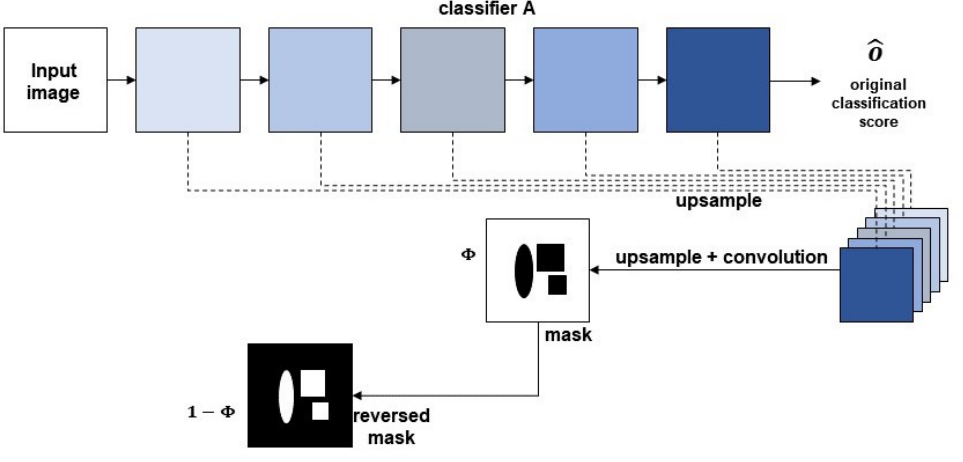
Figure 3. Illustration of the network for the